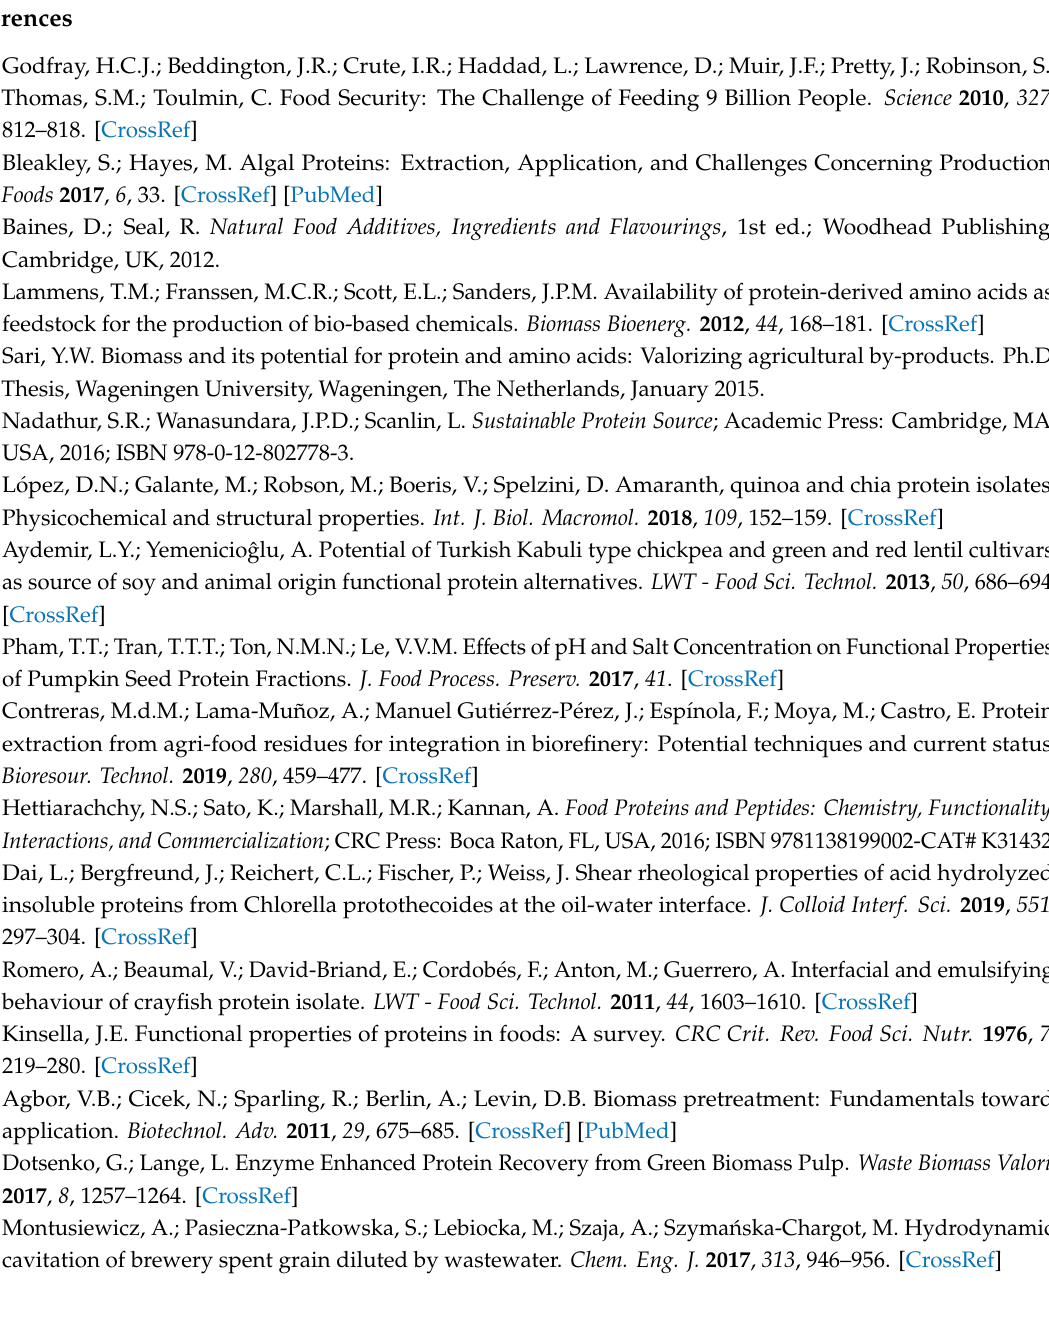
Supplementary Materials: The following are available online. Table S1: The amino acids composition of the studied